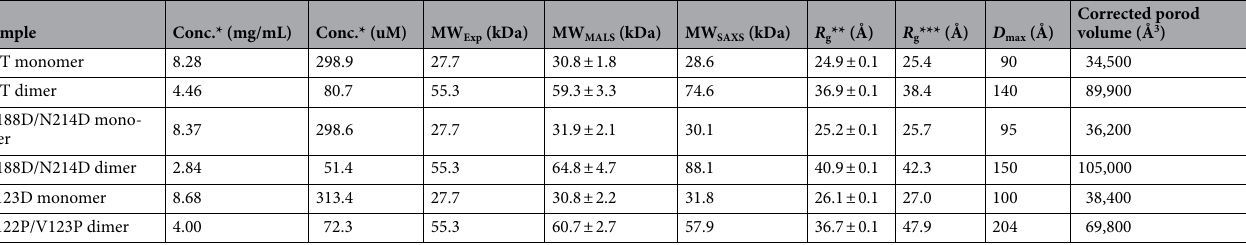
Table 1. Summary of SEC–MALS–SAXS analysis of GRB2 WT and mutants. Conc.—sample concentration at the time of SEC injection; MW Exp —expected molecular weight calculated from primary amino acid sequence; MW MALS —molecular weight determined by MALS; MW SAXS —molecular weight estimated from SAXS using Porod volume; R g **—radius of gyration estimated in reciprocal space from the Guinier plot; R g ***—radius of gyration estimated in real space using the program GNOM; D max —maximum dimension estimated using the program GNOM; Corrected Porod volume—particle volume calculated from Porod’s